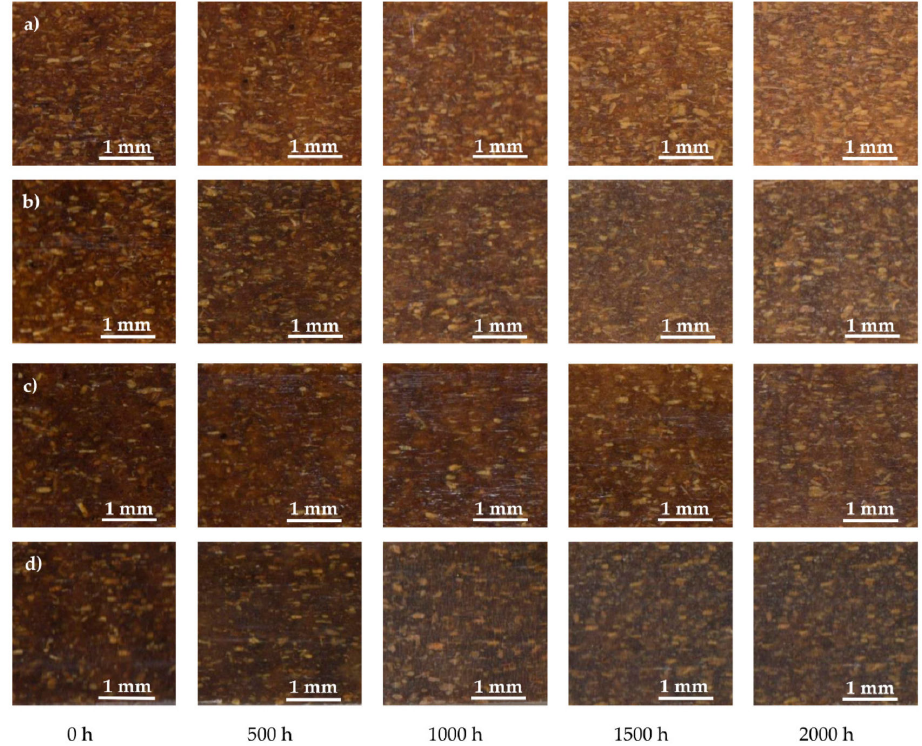
Figure 2. Visual photographs (30 × ) of all groups of composite shells as a function of the weathering time, with: ( a ) WPC-U comprising 20% WF and 2% UV 326; ( b ) WPC-B comprising 12% WF and 8% BF; ( c ) WPC-B-U comprising 12% WF, 8% BF, and 2% UV 326; and, ( d ) WPC-B1comprising 8% WF and 12%